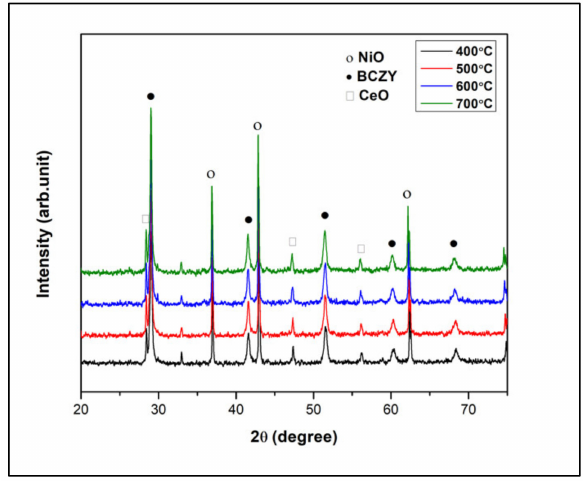
Figure 1. XRD pattern of NiO-BCZY anode composite at four different temperatures (400 to 700 ◦ C).